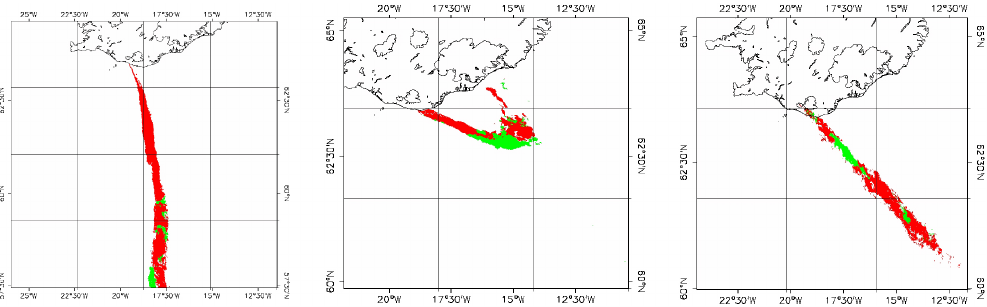
Figure 4. Ash detection maps of validation data sets: 11 May 2010, 14:05UTC (left); 12 May 2010, 12:55UTC (middle); 16 May 2010, 12:30UTC (right). Volcanic ash clouds over sea alone in red, ash clouds over meteorological clouds in